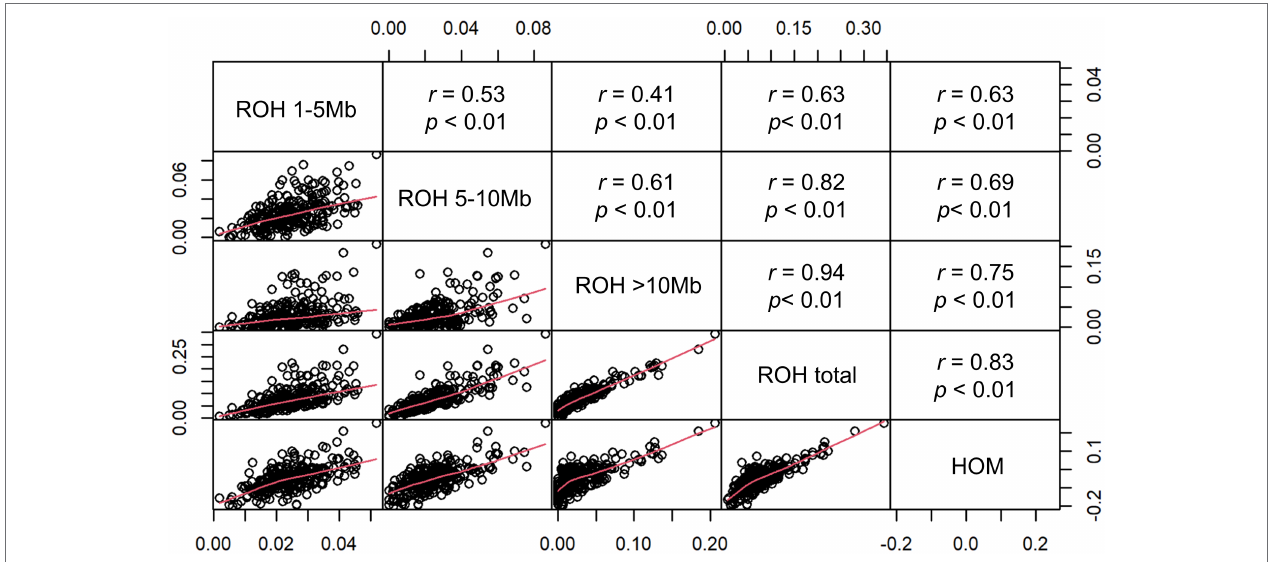
FIGURE 3 | Scatterplots (lower panel) and Pearson’s correlations (upper panel) of the genomic inbreeding coefficients F ROH (F ROH 1 ~ 5 Mb , F ROH5 ~ 10 Mb , F ROH > 10 Mb , and F ROH_total ) and F